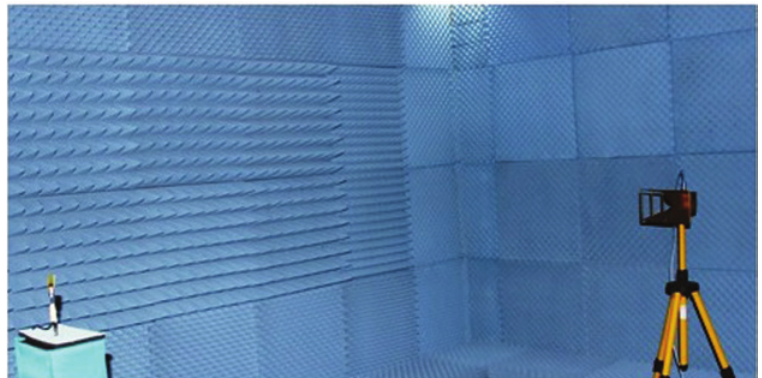
Figure 13: Radiation pattern measurement in the anechoic chamber.